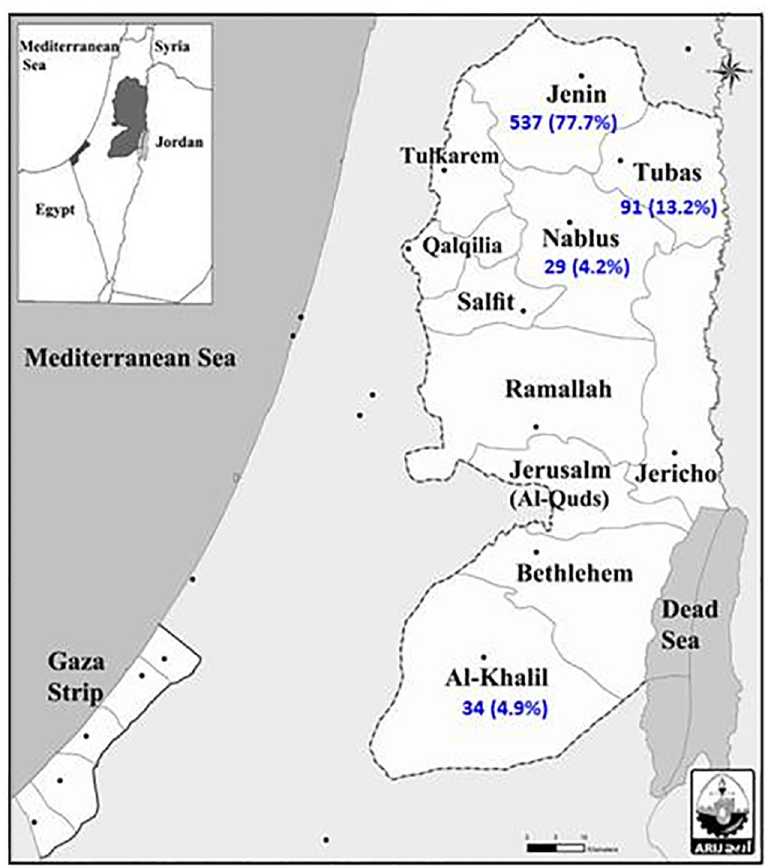
Fig 1. Map of the Palestinian districts investigated, giving the number and the percentages of sand flies collected in each district and in which of the sand flies blood meals were detected and from which animals the blood meals came, including the ones from humans, indicating if leishmanial DNA was detected. Based on the Map of the West Bank and Gaza Strip; Applied Research Institute-Jerusalem (ARIJ), generated by Issa Zboun; using ‘ArcGIS-ArcMap 10.5’.